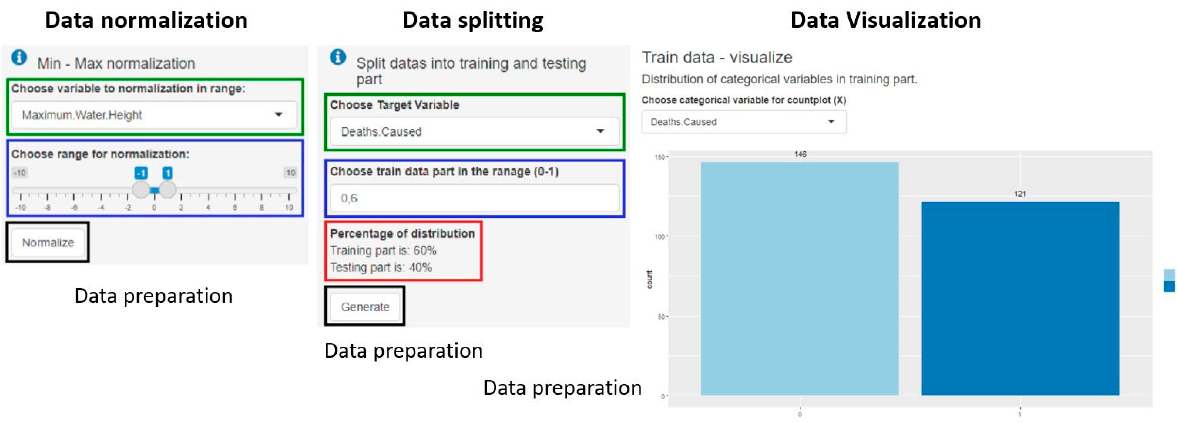
Figure 7. Data normalisation, splitting and visualisation (data preparation).